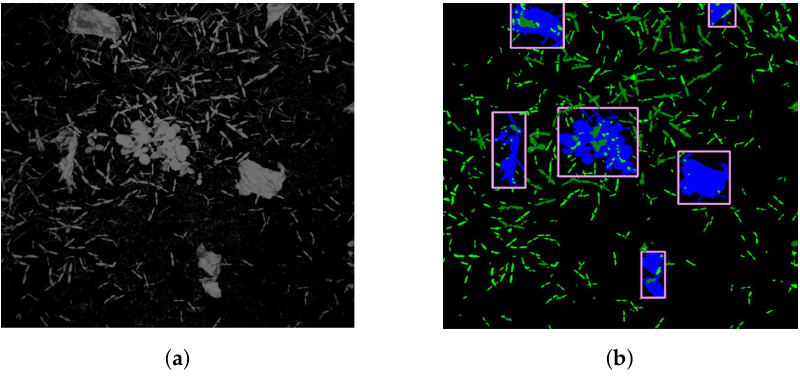
Figure 4. Image processing steps. ( a ) Greyscale output of the RGNIR function. ( b ) Image following thresholding.